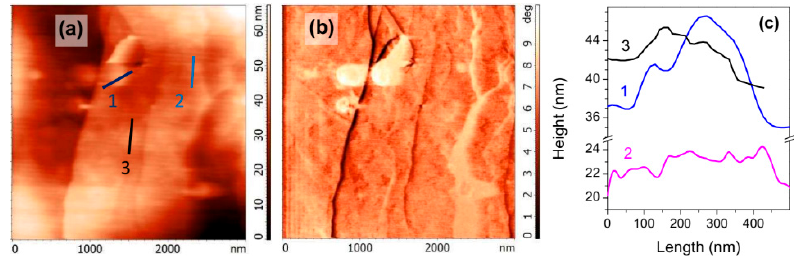
Figure 1. Tapping mode atomic force microscopy (AFM) height ( a ) and phase ( b ) images of highly oriented pyrolytic graphite (HOPG) surface heated to 60 °C and then conditioned in cold water (5 °C) before AFM experiment in ambient water; ( c )—height profiles along lines at ( a ) image.